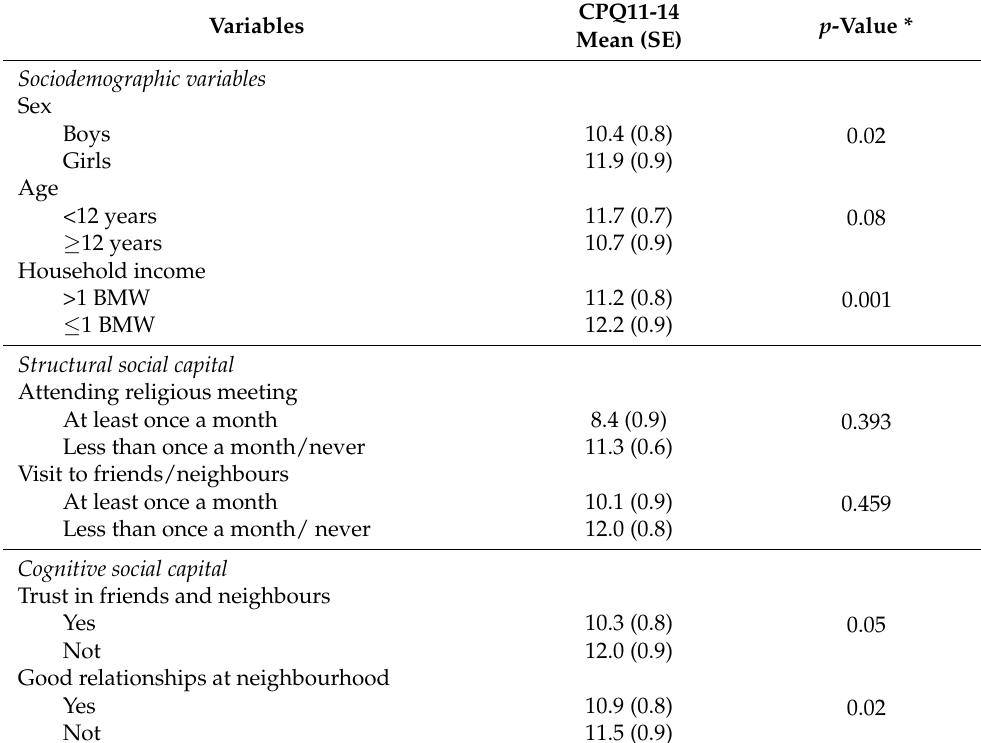
Table 2. Overall OHRQoL (CPQ11-14) scores according to sociodemographic characteristics, social capital variables, and oral health